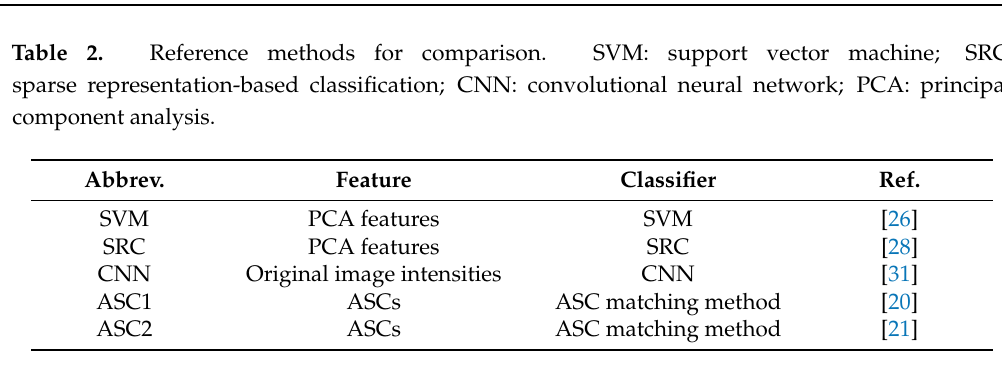
Table 1. Template and test sets used in the experiments. Depr. BMP2